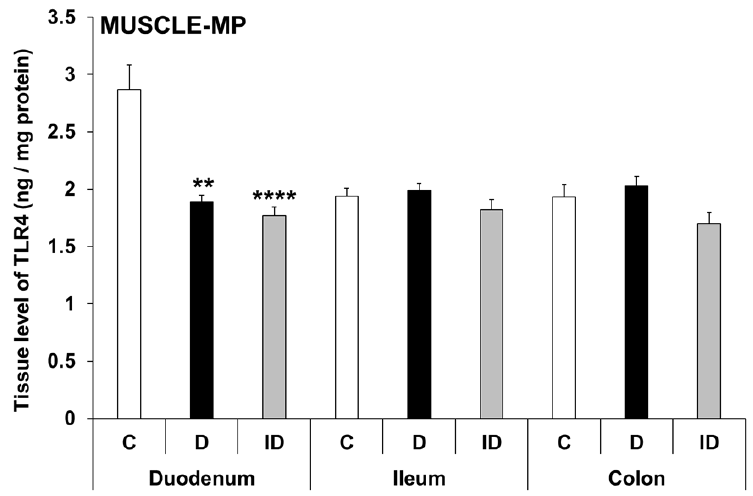
Figure 9. Tissue levels of TLR4 in intestinal smooth muscle layer homogenates including the myen- teric plexus from different gut segments of control, diabetic and insulin-treated diabetic rats. In the diabetics, TLR4 concentration was decreased by more than 30% only in the duodenum relative to controls, which was not prevented by insulin. Statistics: Kruskal-Wallis test with Dunn’s multiple comparisons test. Data are expressed as means ± SEM. ** p < 0.01, **** p < 0.0001 (relative to controls). C—controls, D—diabetics, ID—insulin-treated diabetics.